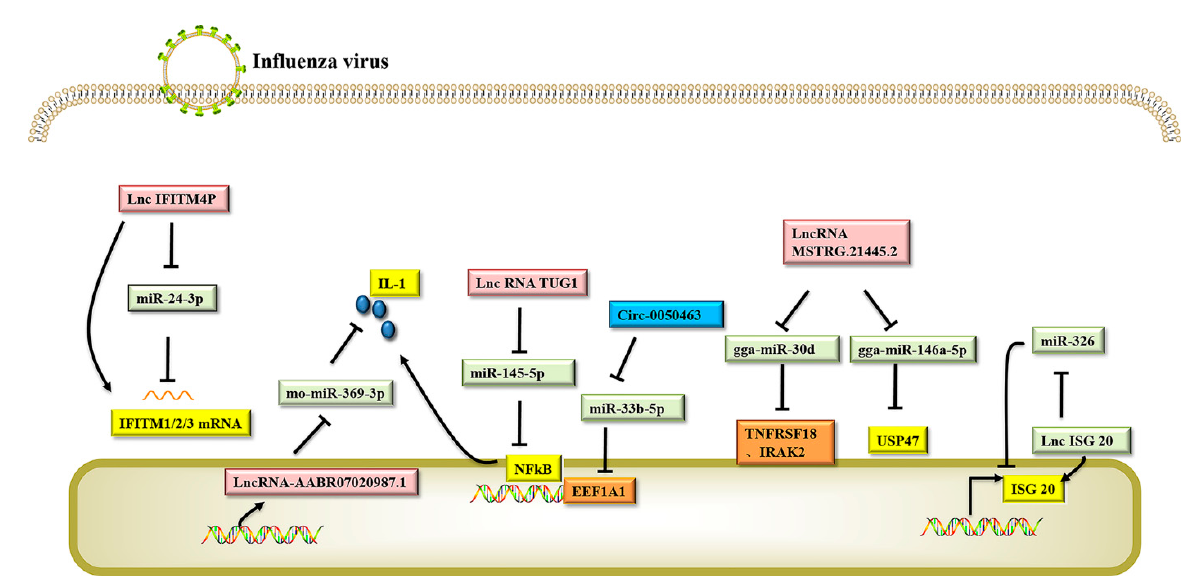
Figure 2. Competitive endogenous RNAs involved in regulating influenza virus replication. The ceRNA interaction network has more complex regulatory mechanisms compared to the simple host non-coding RNA regulating influenza virus replication. The regulatory process involves mutual regulation between non-coding RNA, and also non-coding RNA interaction with host proteins, ultimately enabling regulation of influenza virus replication through a series of complex regulatory mechanisms. (The Pink/blue boxes indicate lncRNA/circRNA that can bind to microRNA; green box indicates the microRNA that binds to the key antiviral protein of the host; The yellow/orange box indicates the host protein that can inhibit/promote the expression of influenza virus during antiviral process).